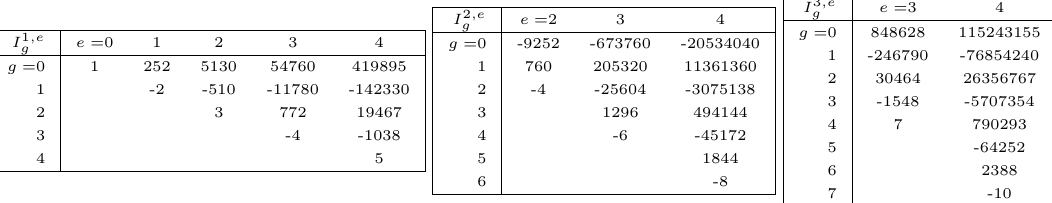
Table 3 . Unrefined BPS invariants for the massless E-string at base degrees b = 1 , 2 ,